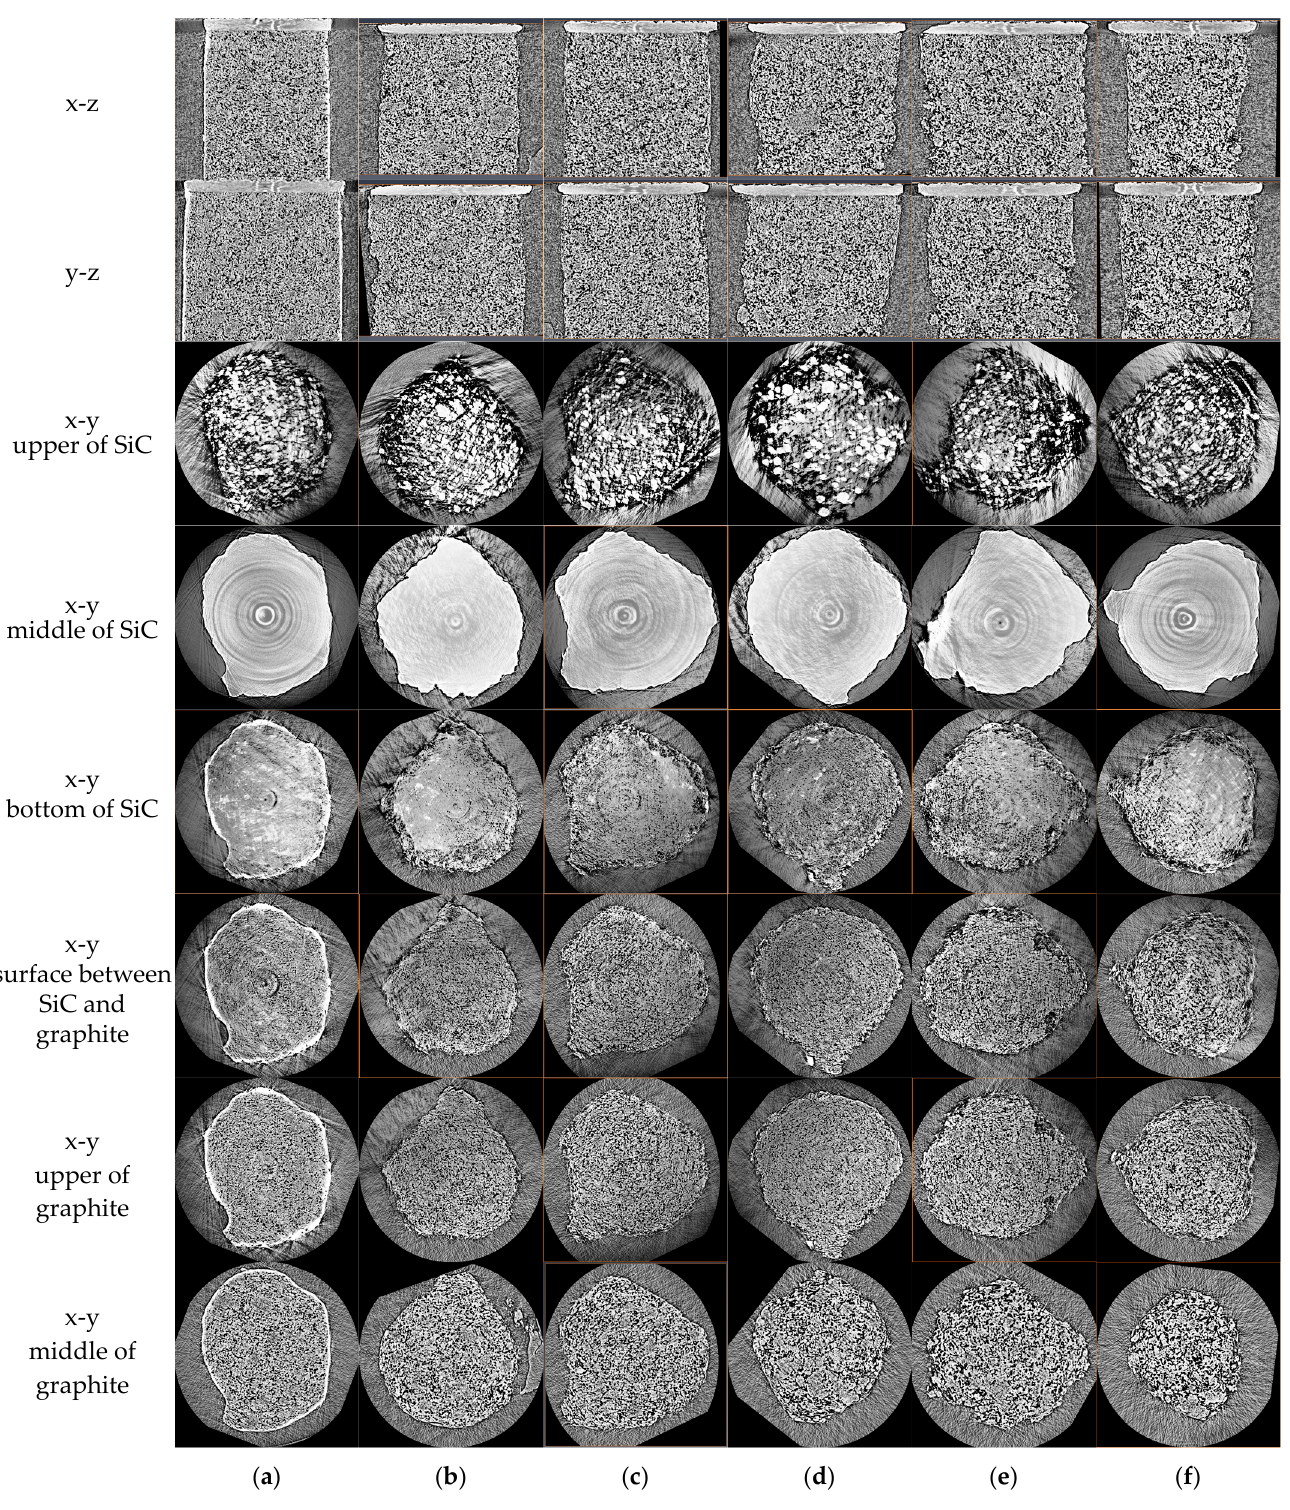
Figure 8. Cross-sections of 3D pictures of partially SiC-coated graphite specimens: ( a ) as-received; ( b ) oxidized for 4 min; ( c ) oxidized for 8 min; ( d ) oxidized for 12 min; ( e ) oxidized for 16 min; ( f ) oxidized for 24 min. The upper and middle cross-sections of the SiC components corresponded to those obtained via scanning electron microscopy (SEM) observations in another study [39] (p. 4). The upper cross-sections of the SiC components were uneven and the middle cross-